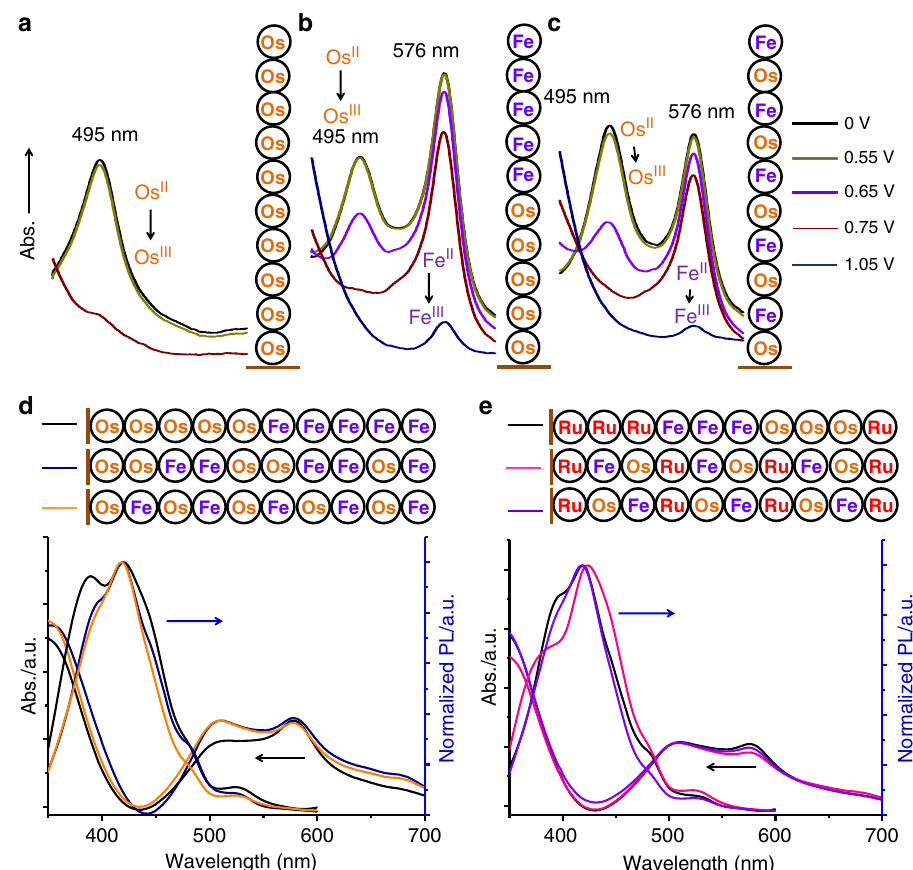
Fig. 5 Distinct UV – vis absorption and photoluminescence spectra of organometallic polymers with different compositions and sequences. a – c Electrochromic behaviors at absorption range between 450 nm and 620 nm on ITO coated glasses at applied different potentials. d , e UV – vis absorption and photoluminescence (PL) spectra of binary and ternary organometallic